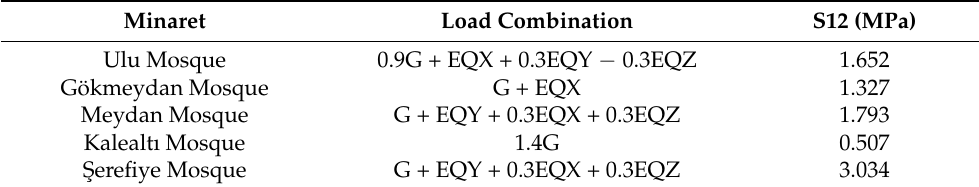
Table 8. Comparison of the maximum shear stresses obtained for Five